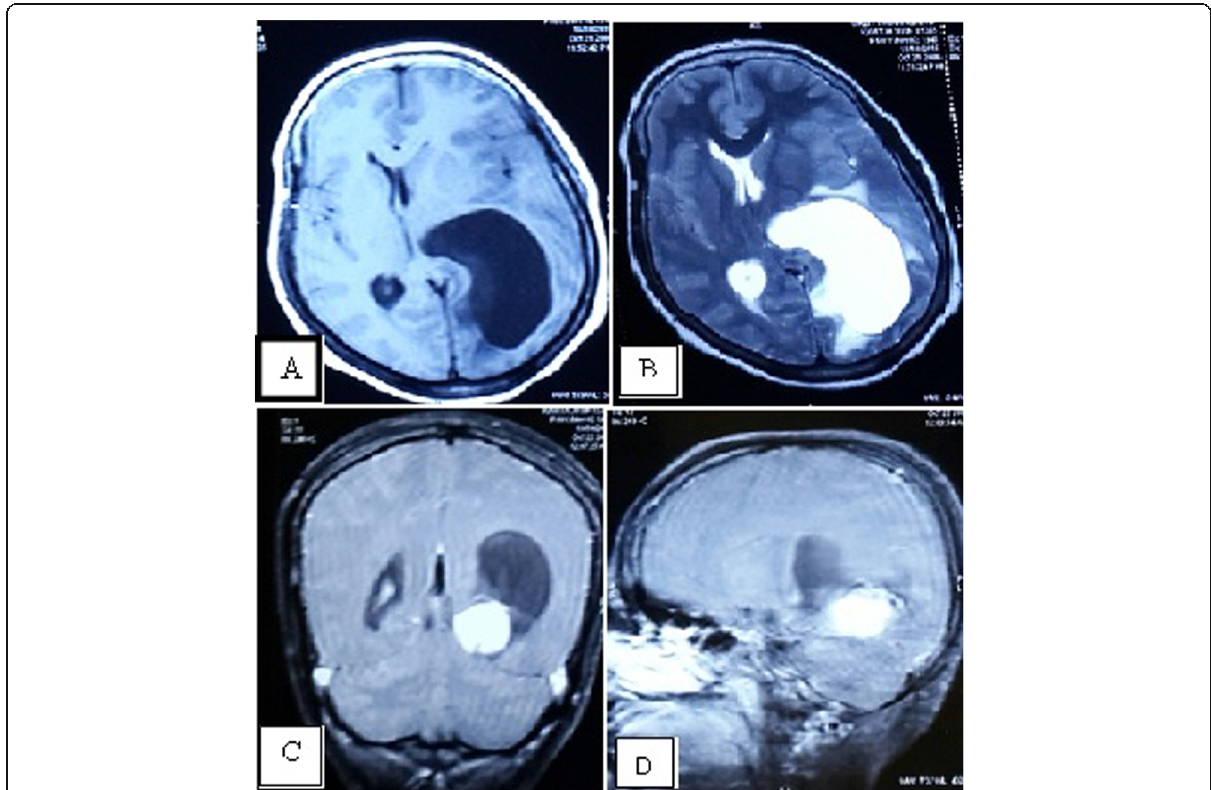
Fig. 1 CEMRI of the brain shows a well-defined solid cystic lesion in the left parieto occipital region. Solid component isointense and cystic component hypointense on T1 axial images ( a ). Solid component shows intense enhancement on T1 contrast coronal and sagittal images ( c , d ), Solid component isointense and cystic component iso- to hyperintense on T2 axial images ( b